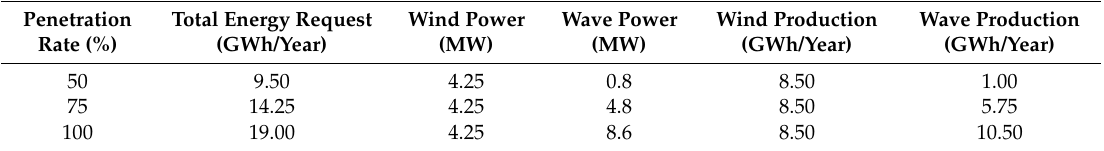
Table 5. Emission factors used for public transport in Province of Trapani [18].